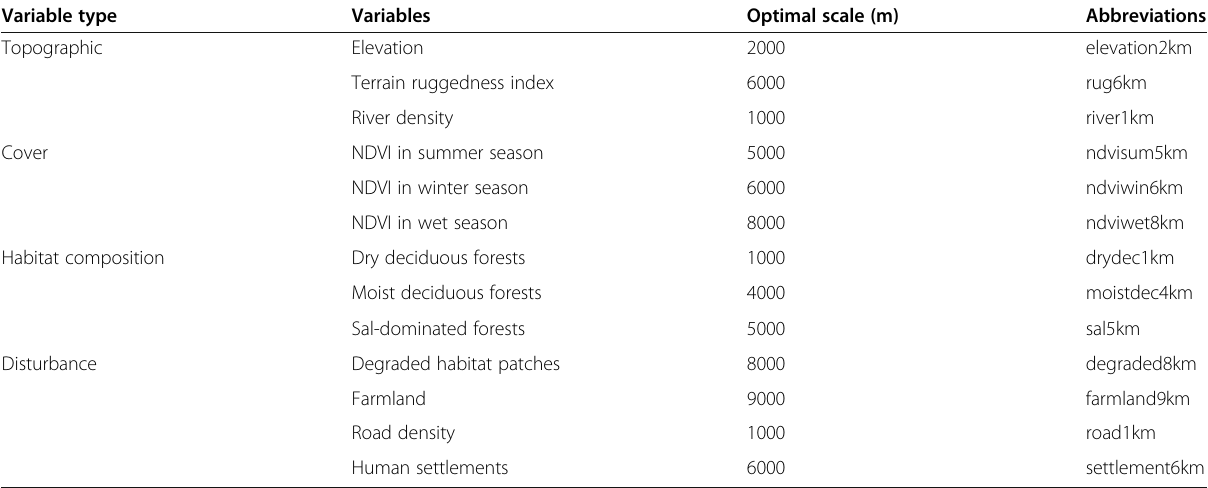
Table 1 Predictor variables included in the random forests modeling and the scales retained in the univariate scaling step of sloth bears in Bandhavgarh Tiger